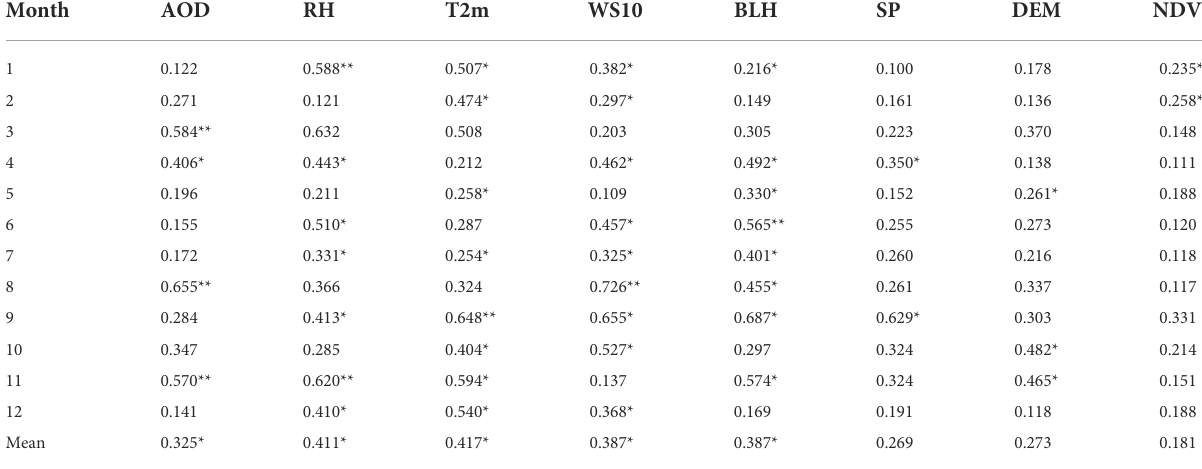
TABLE 2 Unsigned correlation matrix between different explanatory variables and PM2.5 from January to December.